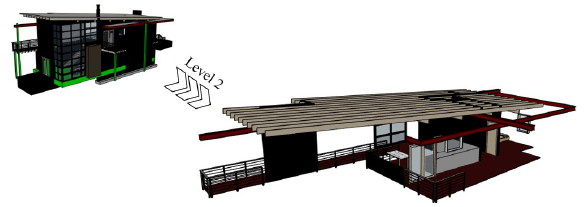
Figure 4. Query for the second